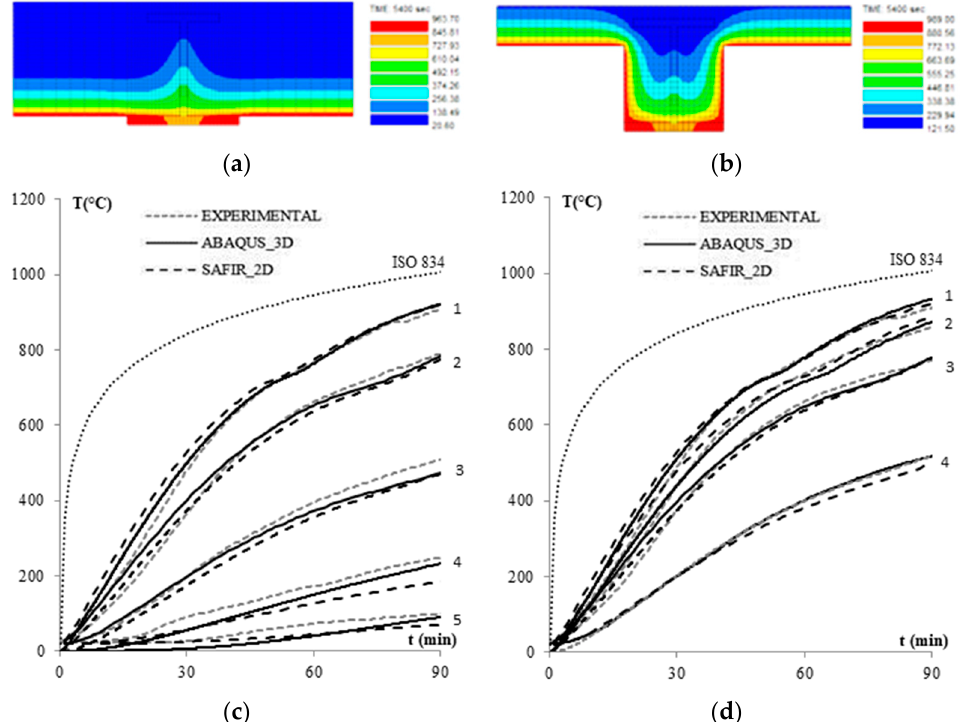
Figure 7. Thermal comparisons for WFRC 67756: ( a ) Thermal contours at section AA’ after 90 min, ( b ) Thermal contours at section BB’ after 90 min, ( c ) Test vs. FEM at section AA’ ( d ) Test vs. FEM at section BB’.